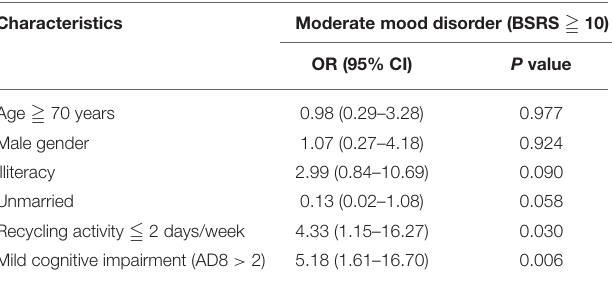
TABLE 6 | Logistic regression of factors influencing moderate mood disorder in 985